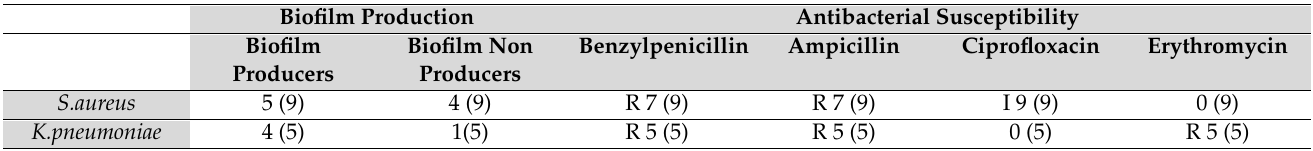
Table 2. Biofilm production and antibacterial susceptibility profile of S. aureus and K. pneumoniae isolates obtained with punch biopsy from tonsils of patients undergoing